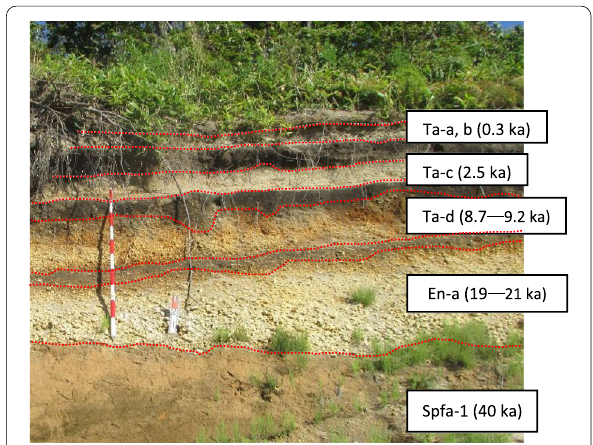
Fig. 3 The tephra layers from Ta-a until Spfa-1 which located nearby the research area (Minato et al. 1972; Nakagawa et al. 2018;